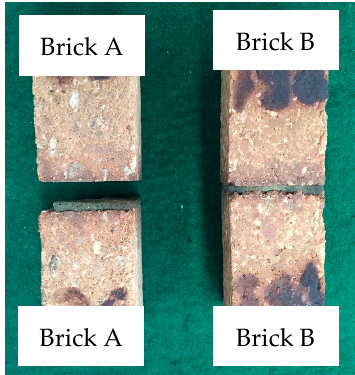
Figure 8. Visual aspect of the bricks A and B after sandwich coating test using cement raw meal as received.